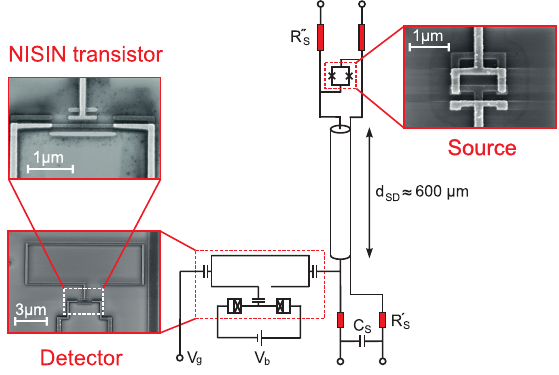
Figure 4. Equivalent diagram of the complete circuit consisting of the source, the detector and the transmission line coupling. ( Lower left inset ): SEM picture of the detector circuit; ( Upper left inset ): Close-up SEM picture of the detector showing the NISIN transistor structure; ( Upper right inset ): SEM picture of the SQUID (microwave